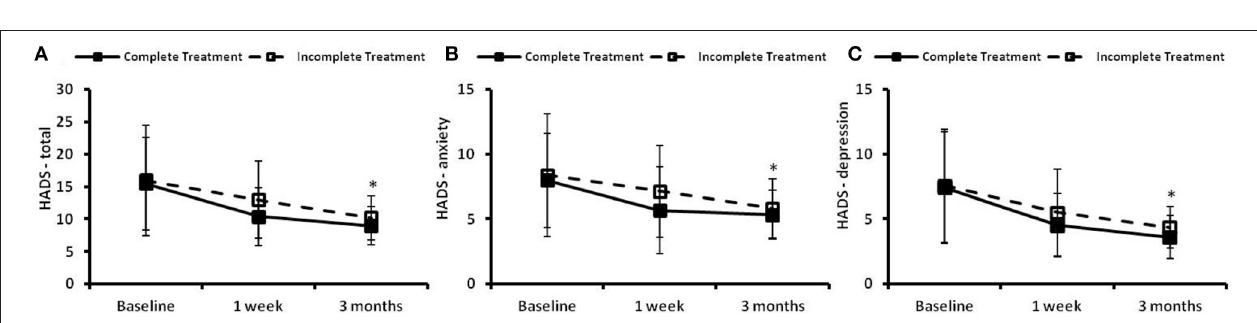
FIGURE 5 | The hospital anxiety and depression scale (HADS) at the preintervention baseline, and 1 week and 3 months following cognitive behavioral treatments for insomnia (CBTI). (A) HADS–total; (B) HADS–anxiety; (C) HADS–depression. *Indicates significant differences ( p < 0.05) for the time effect. Complete treatment group, n = 58; incomplete treatment group, n =